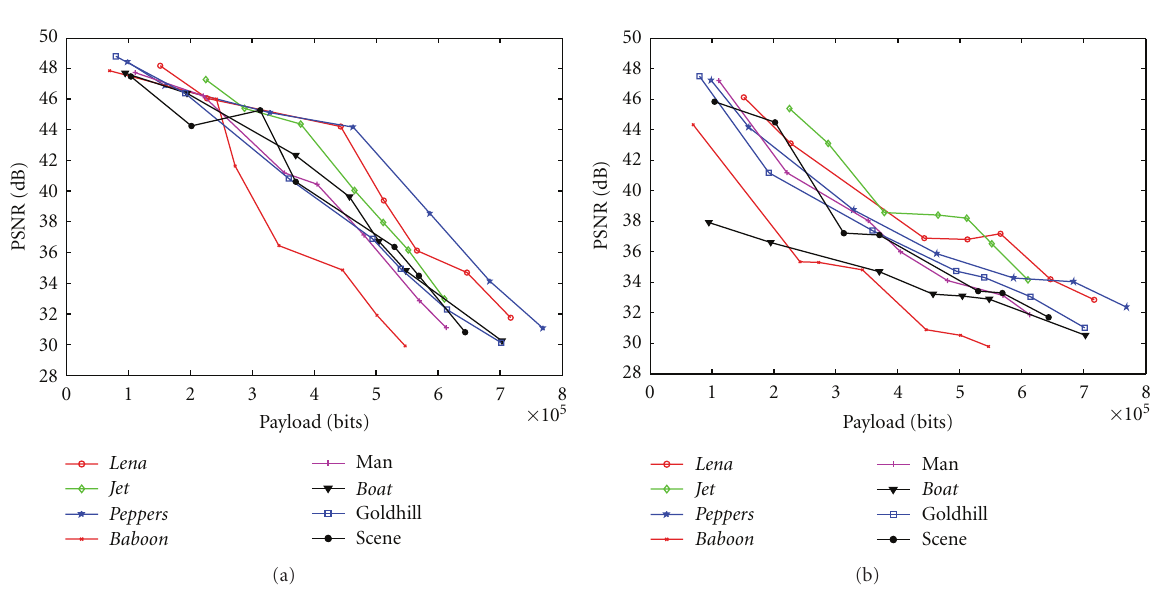
integer k is set to 1. A tradeo ff between the PSNR (dB) and the payload (in bits) for the stego-images 1 and 2 generated by the proposed method using various β is drawn in Figure